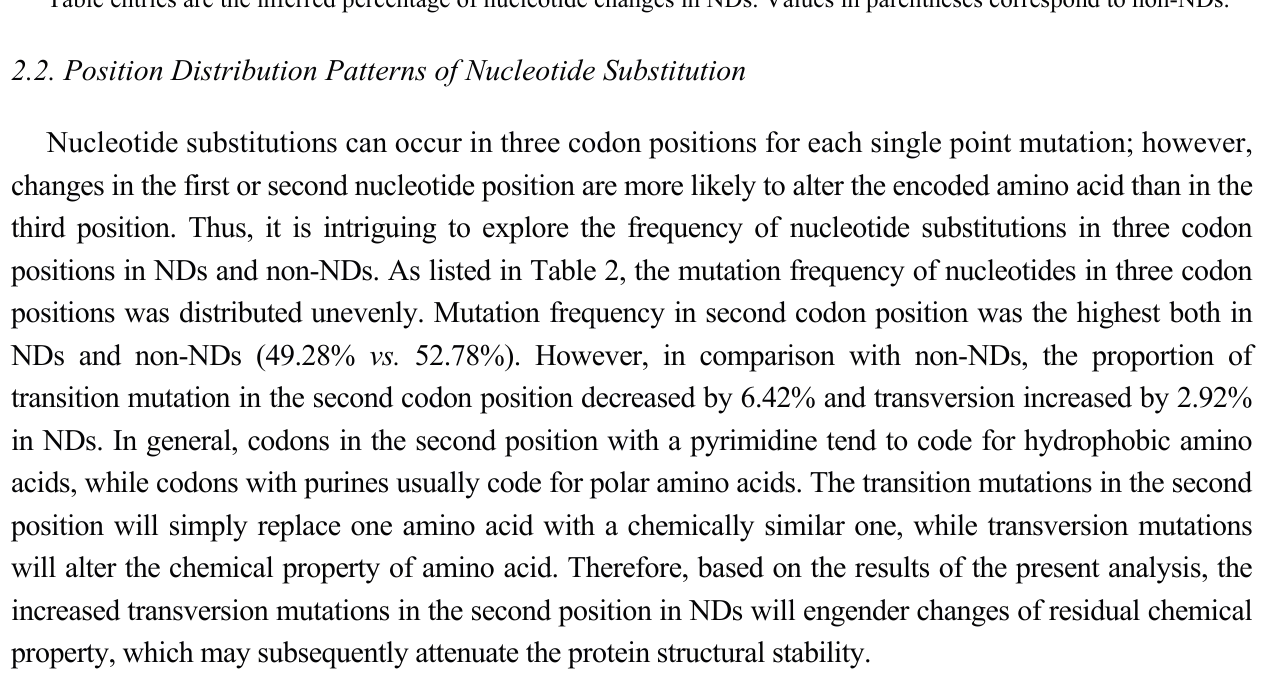
Table 2. Position distribution patterns of nucleotide substitution in NDs and